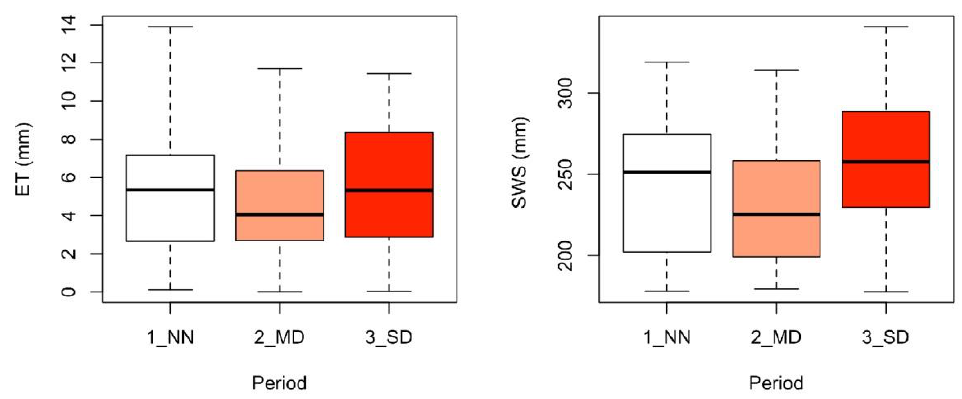
Figure 6. Box plots of daily evapotranspiration (ET) ( left figure ) and monthly soil water storage (SWS) ( right figure ) in a seasonally dry Atlantic Forest (SDAF) under different drought conditions (NN = near normal; MD = moderately dry; SD = severely dry).